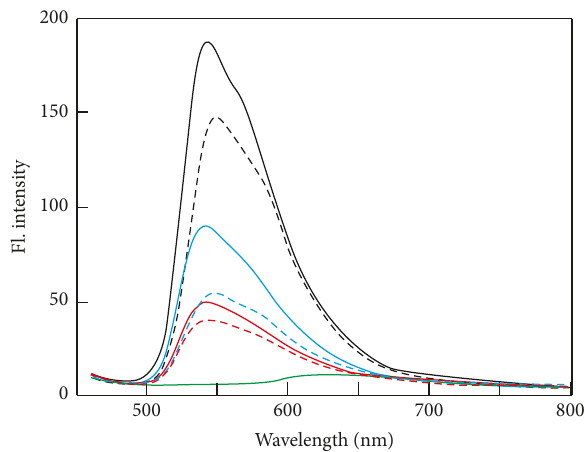
Figure 6: Fluorescence emission spectra (a.u.) of TO in the presence of HTR (solid lanes) and THR (dashed lines) in mRB buffer. The spectra without the presence of metal cations with 50mM NaCl and 50 mM KCl are represented by black, blue, and red lines, respectively. The molar ratio of DNA :ligand is 1: 5. Fluorescence emission of TO is shown in green.